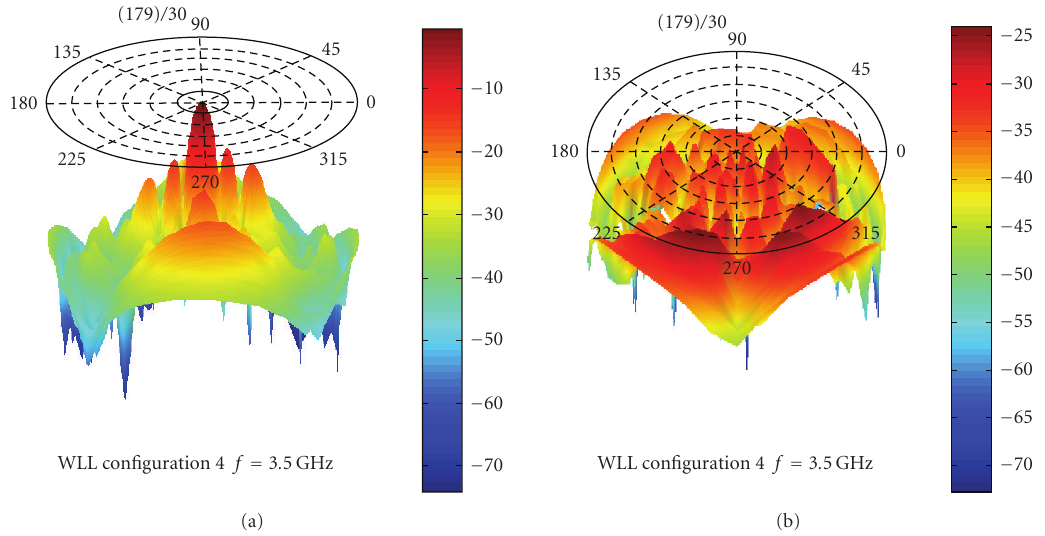
Figure 16: Pattern measurements. Three-dimensional pattern at 0 ◦ pointing direction. (a) Copolar patterns, and (b) cross-polar patterns.